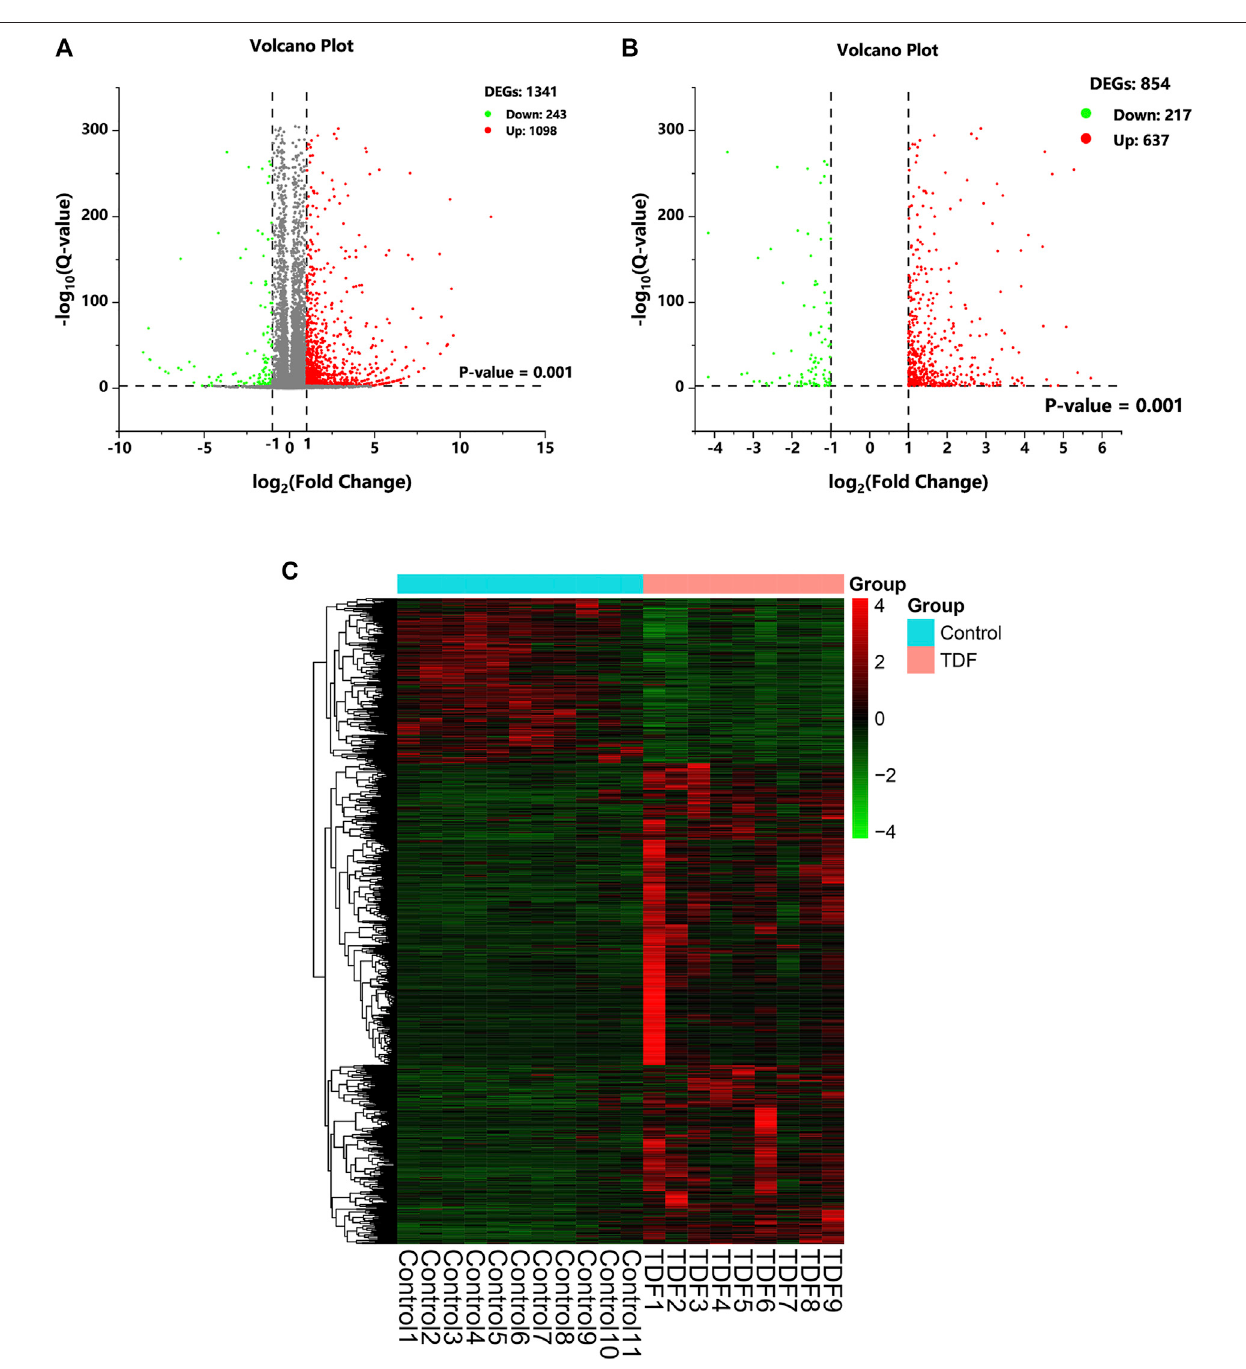
FIGURE2| Differentiallyexpressedgenes(DEGs)inresponsetoTDF. (A,B) ThevolcanoplotofDEGs.Thecutoffvaluesfoldchange ≥ 2andQ-value ≤ 0.001were utilized to identify DEGs. Downregulated DEGs are marked in green, upregulated DEGs are marked in red, and unchanged genes are marked in gray. (C) Hierarchical clustering of